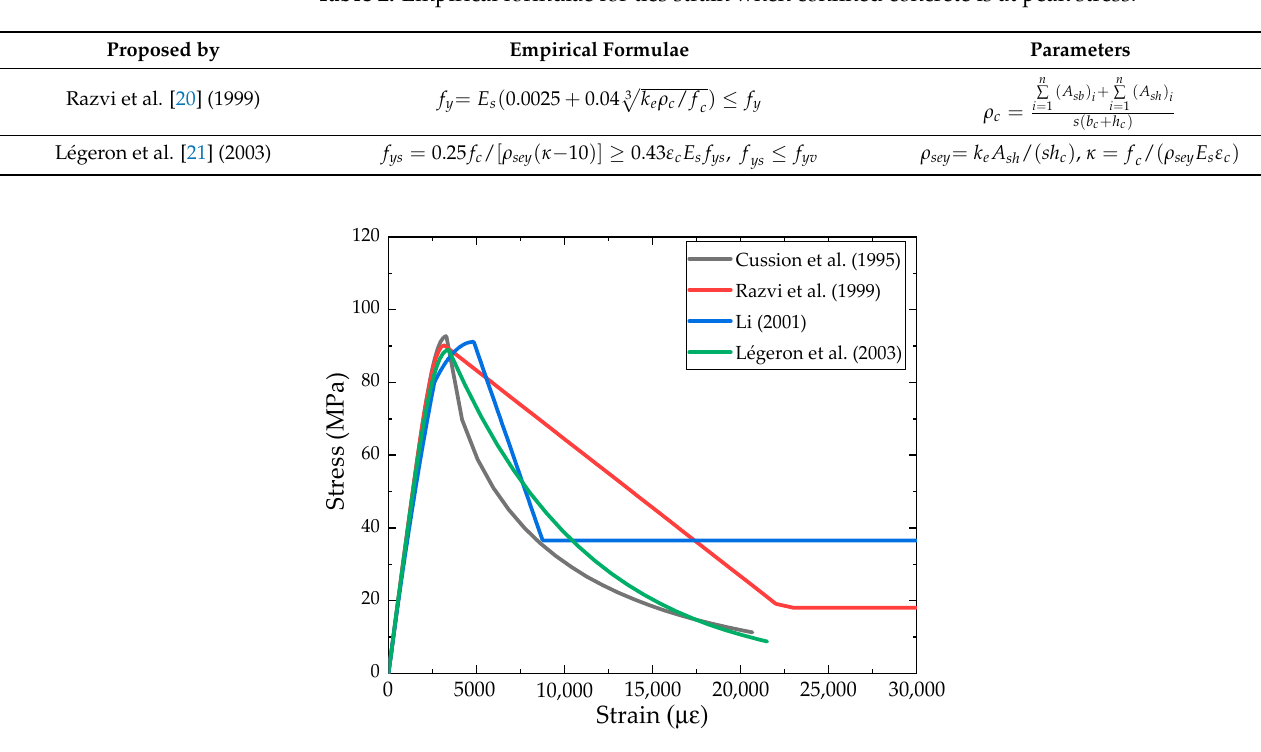
30,000 Figure 2. Comparison of the main models ( 𝑓 (cid:3030) = 100 MPa) [9,15,20,21]. Figures 1 and 2 show that the ascending portion of each model is basically similar, which is mainly because the same ascending portion function is adopted for Cussion’s, Razvi’s, and Légeron’s models. However, the nonlinearity before peak stress in Li’s model is more obvious than that in the other models. For the descending section, the di ff erences among the models are signi fi cant; the residual platform value of Li’s model is higher than that of the other models. The descending portion of Razvi’s model is the slowest, and that of Li’s model is the steepest. 3. Details of the Proposed Model 3.1. Normal Triaxial Compression Model To establish a ties-con fi ned high-strength concrete stress–strain model, the law of strength and deformation of high-strength concrete under uniform lateral con fi nement needs to be determined fi rst. In this study, we used the results of normal triaxial experi- ments on high-strength concrete from related studies [24–33] to establish the relationship between the peak stress, peak strain, and lateral con fi nement ratio ( 𝑓 (cid:3039)(cid:3032) /𝑓 (cid:3030) ) under uniform lateral con fi nement. The cylindrical compressive strength ranges from 60 MPa to 120 MPa,